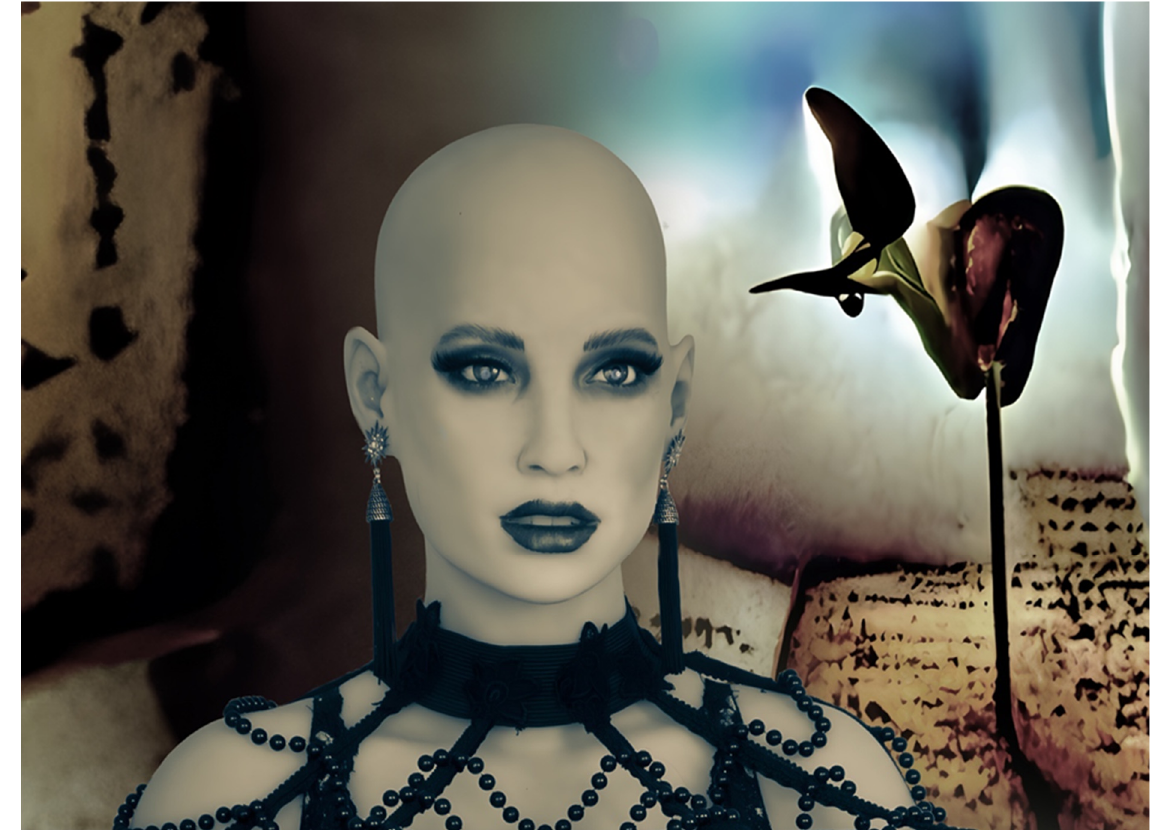
Figure 4. Madeleine + What is poetry? By Graeme Revell, 2022. Photograph, GPT-2/DALL-E2 image and text.